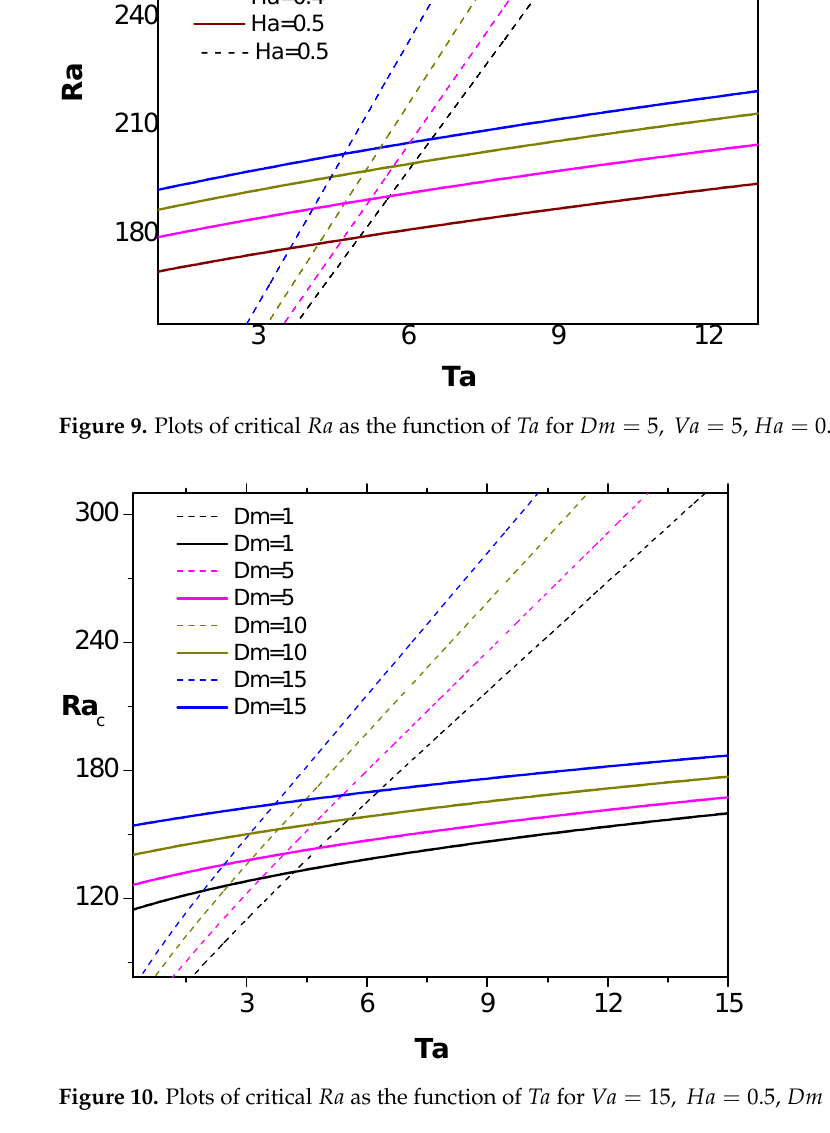
and Ra oc , implying that Dm has a c c